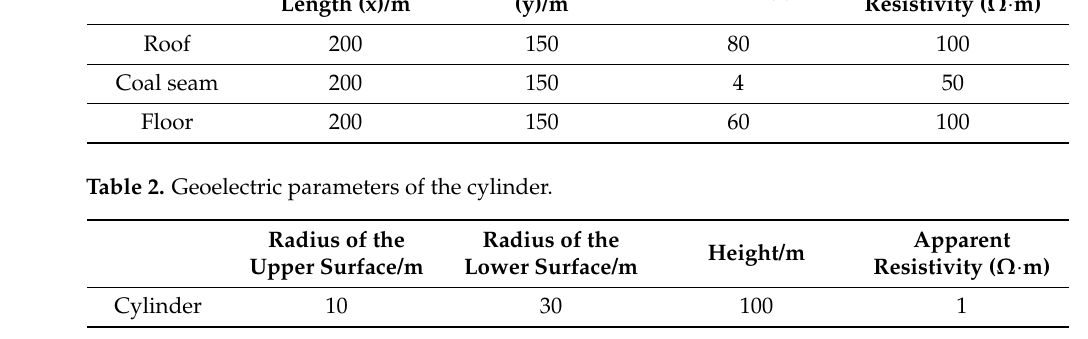
100 Table 2. Geoelectric parameters of the cylinder. Radius of the Upper Surface/m